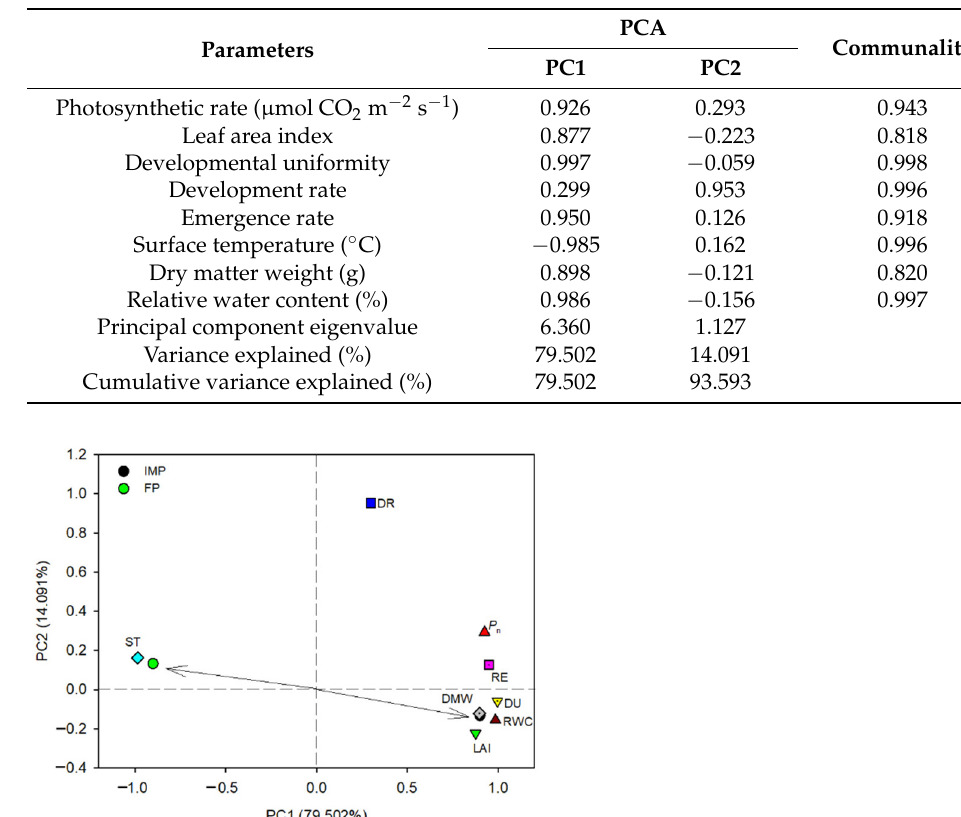
Table 4. Results of the principal component analysis (PCA) about eight crop parameters.